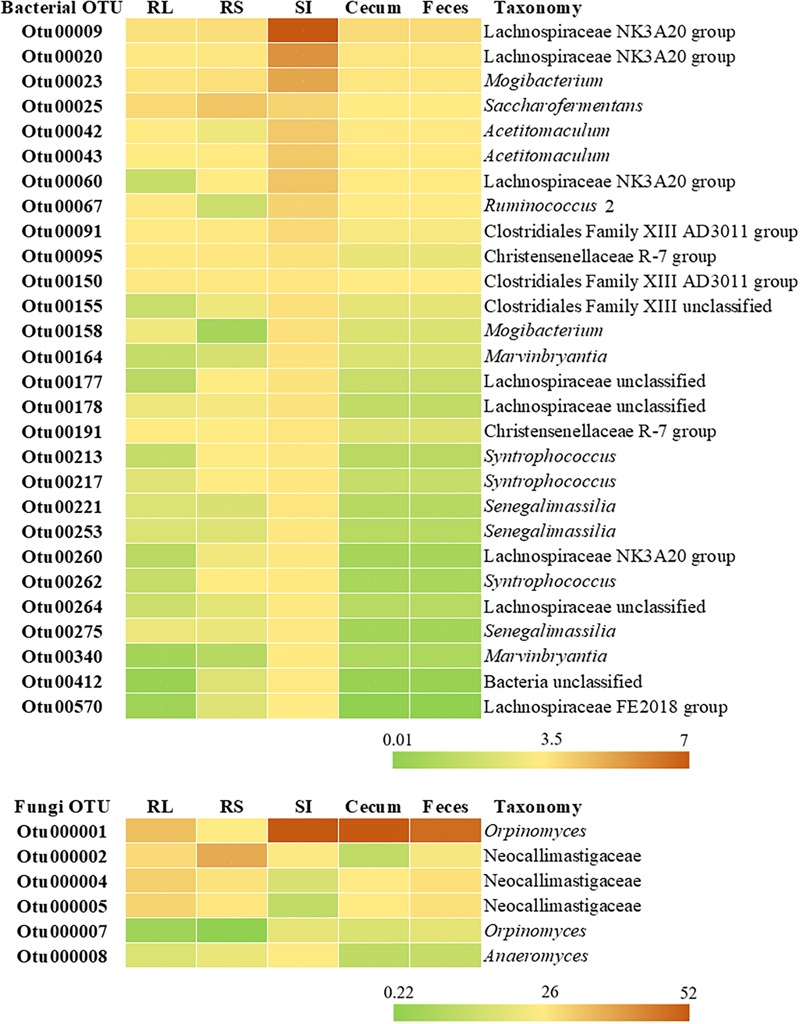
Heatmap representing the relative abundance (%) of bacterial and fungal OTUs shared between rumen liquid (RL), rumen solids (RS), small intestine (SI), and cecum and feces. The taxonomy for each OTU is given at the highest classifiable level.